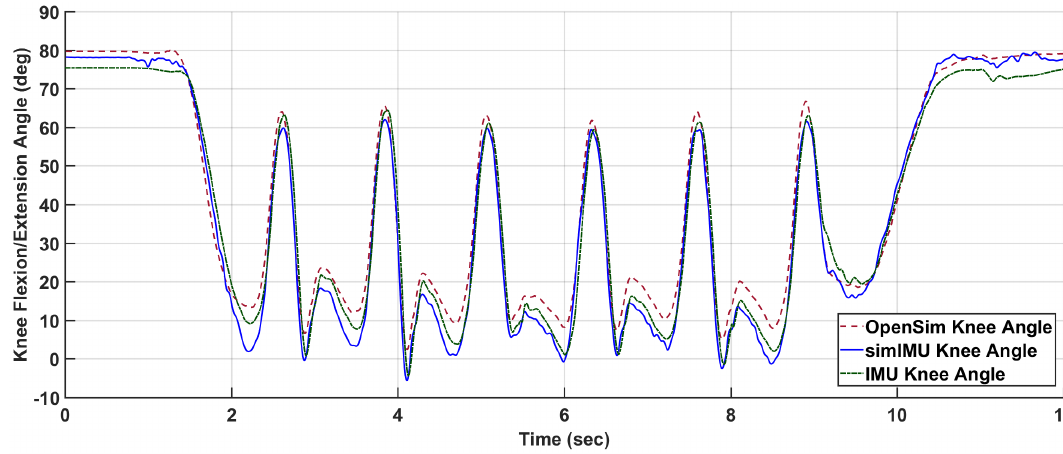
Figure 2 has been updated to represent the new results.